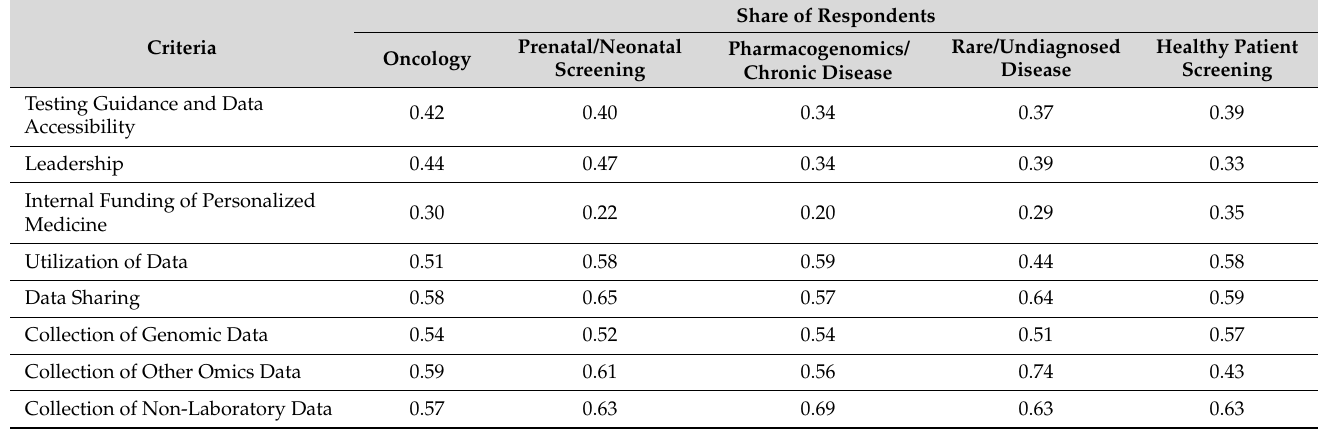
Table 5. Correlation between criteria score and indication